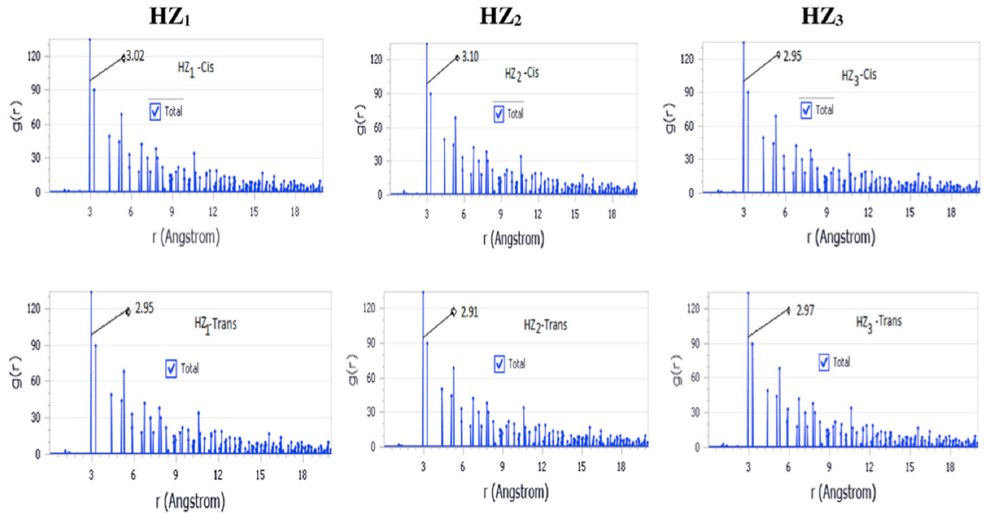
Figure 5. Radial Distribution (g(r)~r) Functions for (Fe (111)/(E&Z) ‐ HZi/Gas phase) systems at 308 K (Belghiti et al . , 2019) [66].